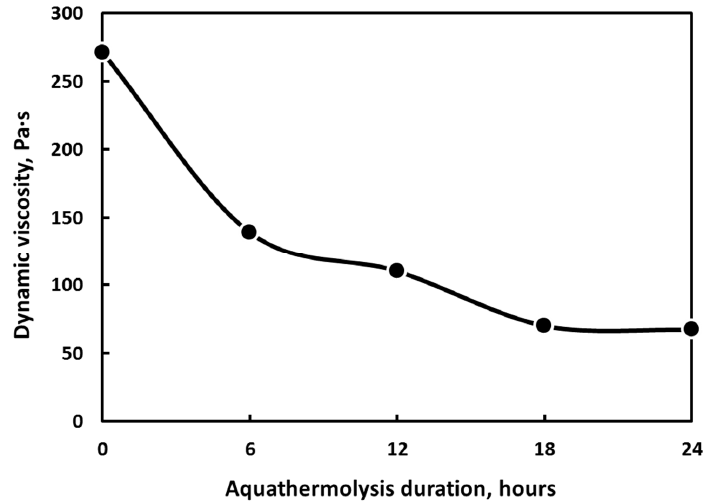
Figure 5. The relation between the viscosity of crude oil and the duration of the aquathermolysis process in the presence of a nickel-based catalyst (5 s − 1 ).